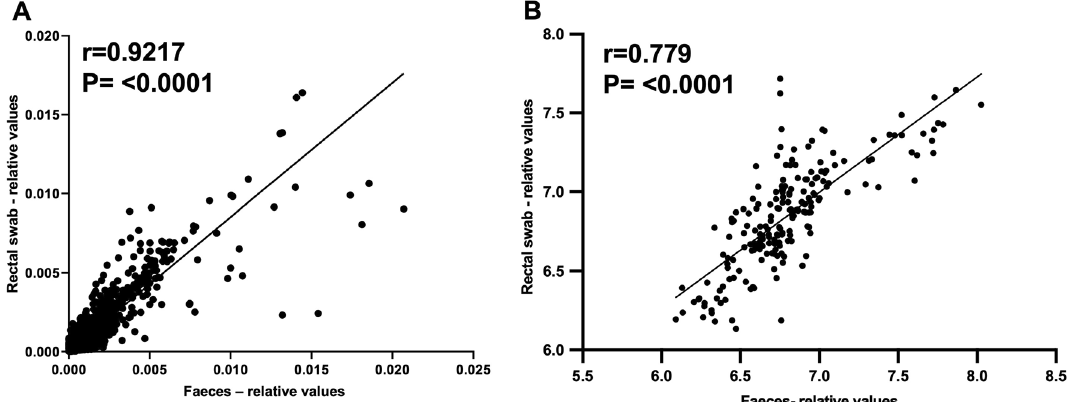
Figure 2. Comparison of gut microbial functionality in matched faeces vs rectal swabs. ( A ) Correlation of swab and faecal KEGG orthologue predicted gene abundance data obtained from Tax4Fun2, quantified as relative units (performed using Pearson’s coefficient); ( B ) correlation of all relative abundance values (log transformed and PQN normalised) for identified metabolites from faecal and swab samples (performed using Pearson’s coefficient). For ( A ), each dot represents paired stool and swab predicted gene abundance values for a particular KEGG orthologue for a particular sample; for ( B ), each dot represents paired stool and swab relative abundance values for a particular metabolite for a particular sample. Faeces: n = 10 samples; swabs: n = 10 samples.